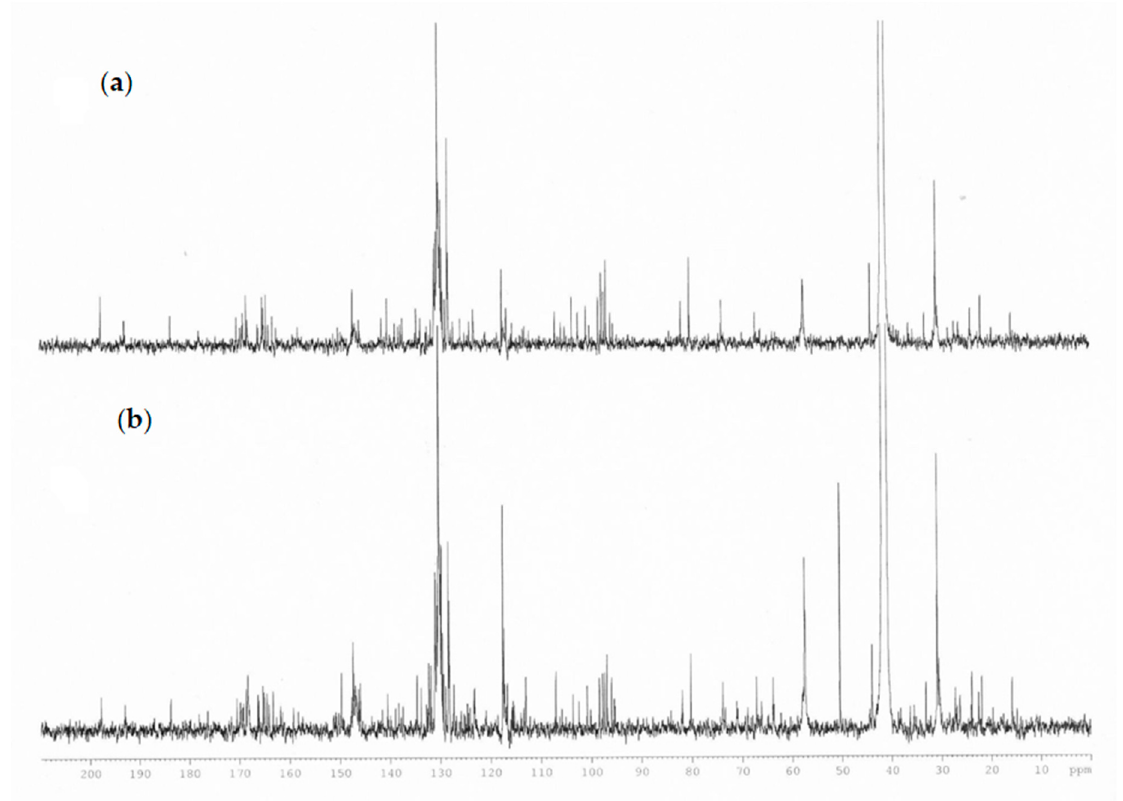
Figure 4. Comparison of 13 C-NMR spectra of propolis extract ( a ) plains sample ( b ) hills sample.